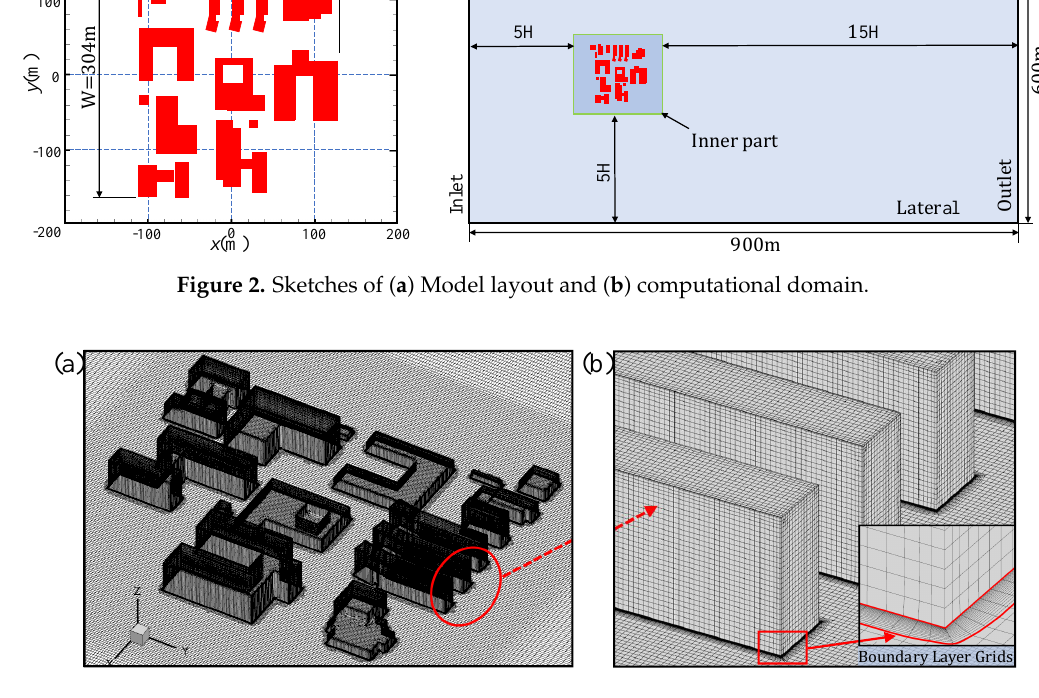
Figure 3. ( a ) Mesh distribution of the building group and ( b ) the vicinity boundary layer